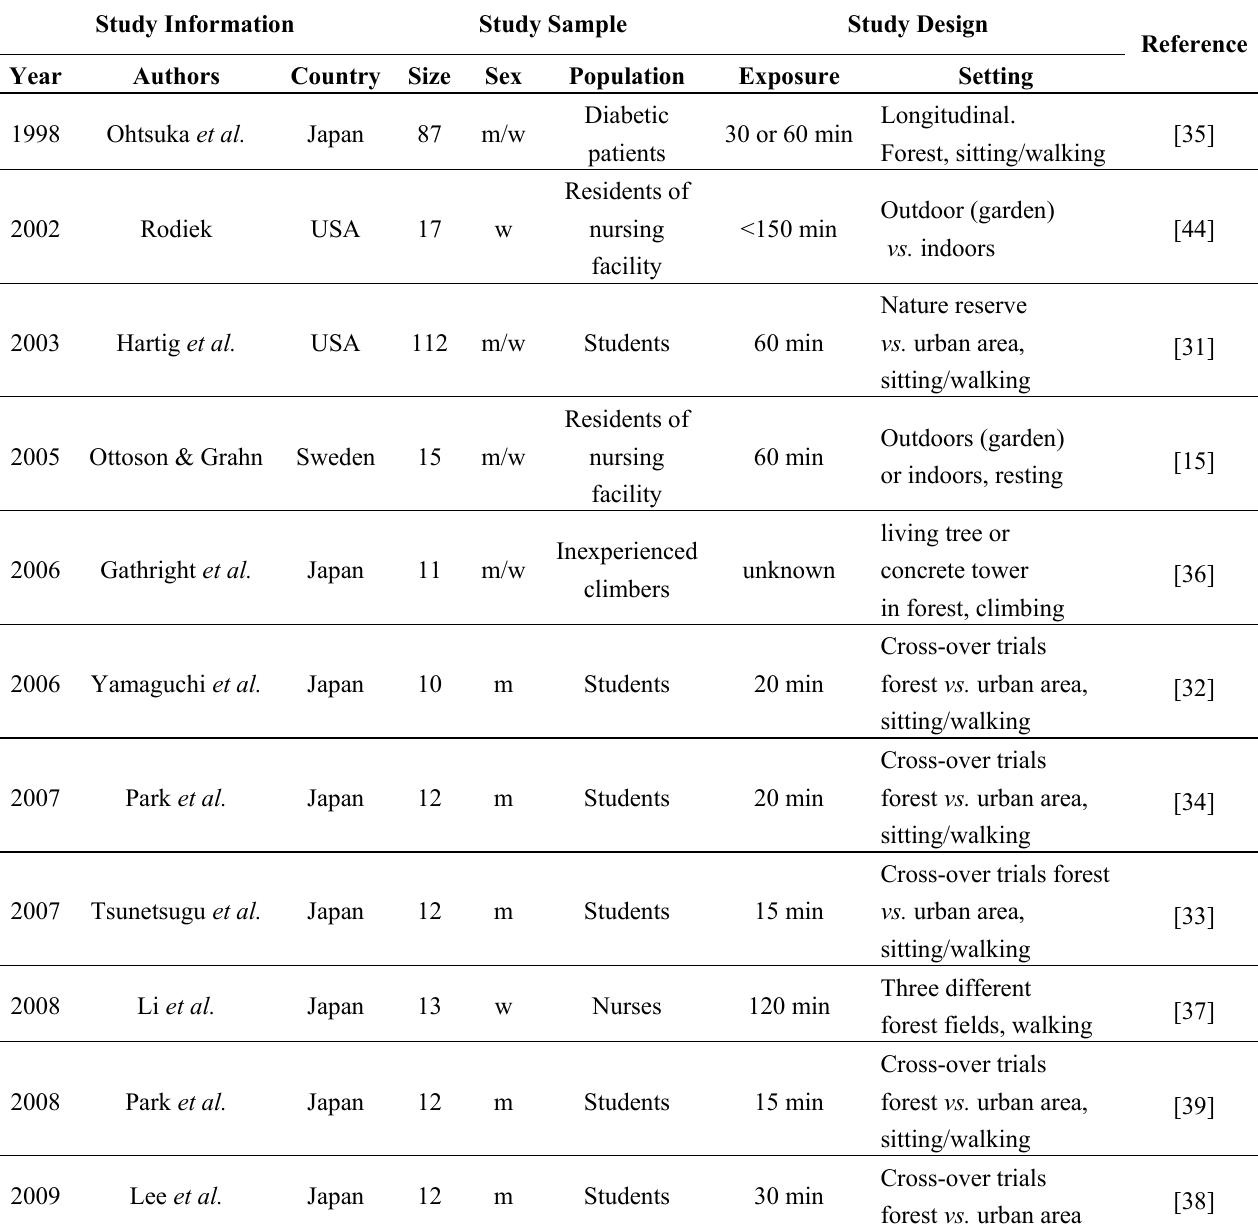
Table 1. Description of study characteristics of reviewed article (n = 17) stratified